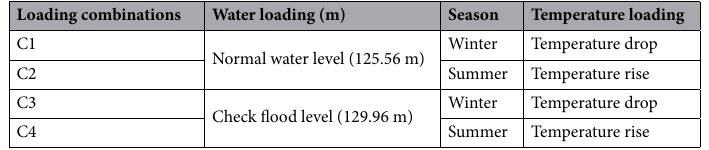
Table 4. Loading combinations for numerical